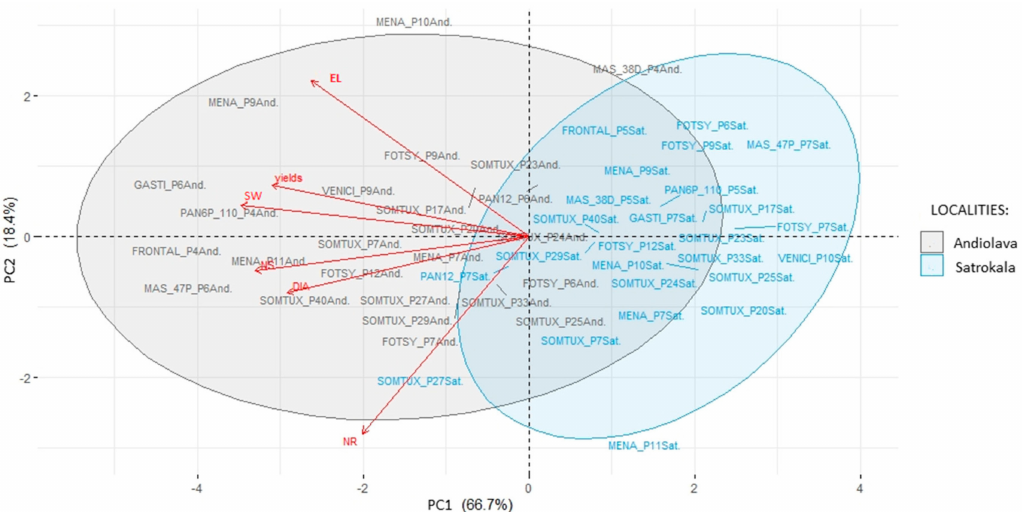
Figure 3. Principal component graph of the half-sib progeny vegetative and productive traits in the two localities. And. = Andiolava; Sat. = Satrokala; NR = number of rank/ear; DIA = ear diameter; NS = number of seed/ear; SW = seed weight/ear; EL = ear length.